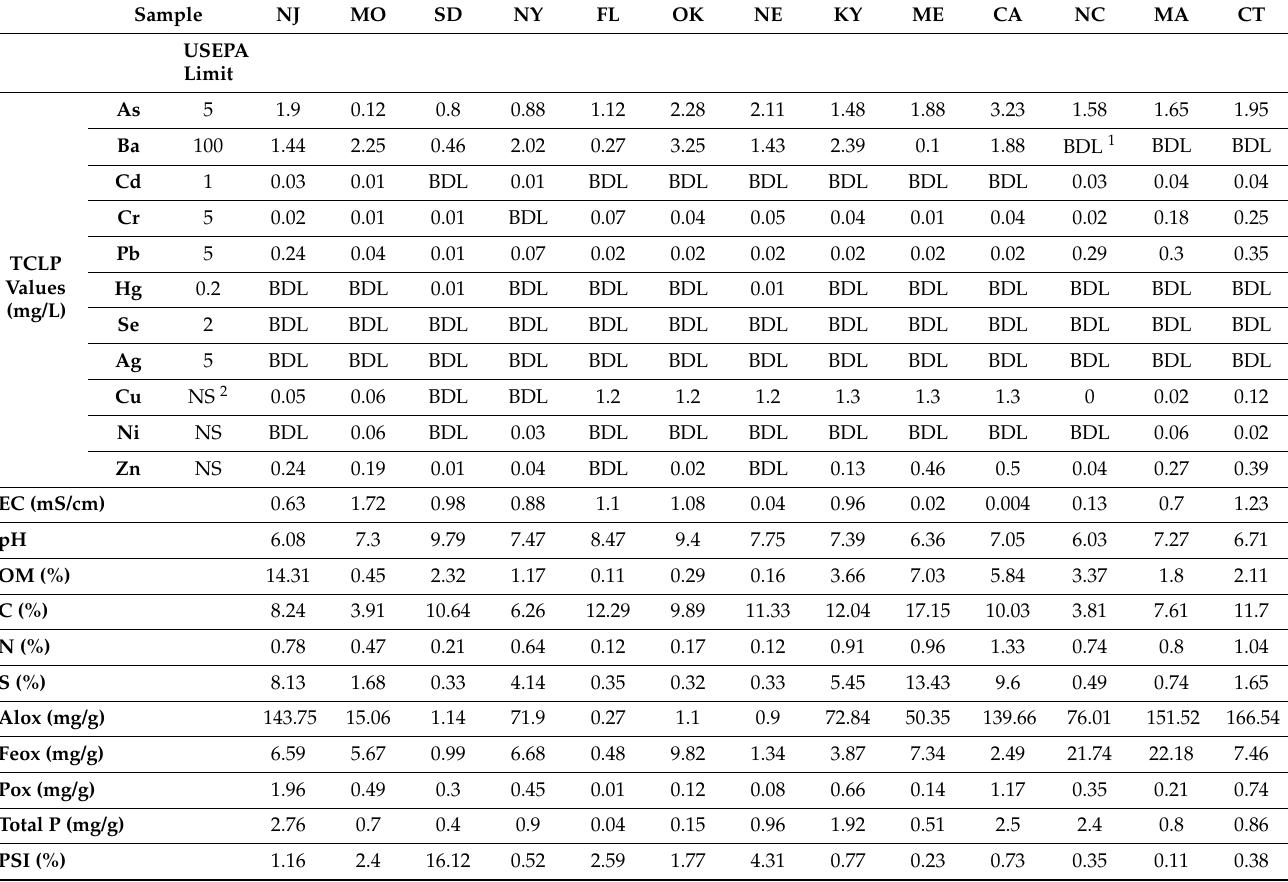
Table 1. Toxicity characteristic leaching procedure (TCLP) values and general chemical properties of